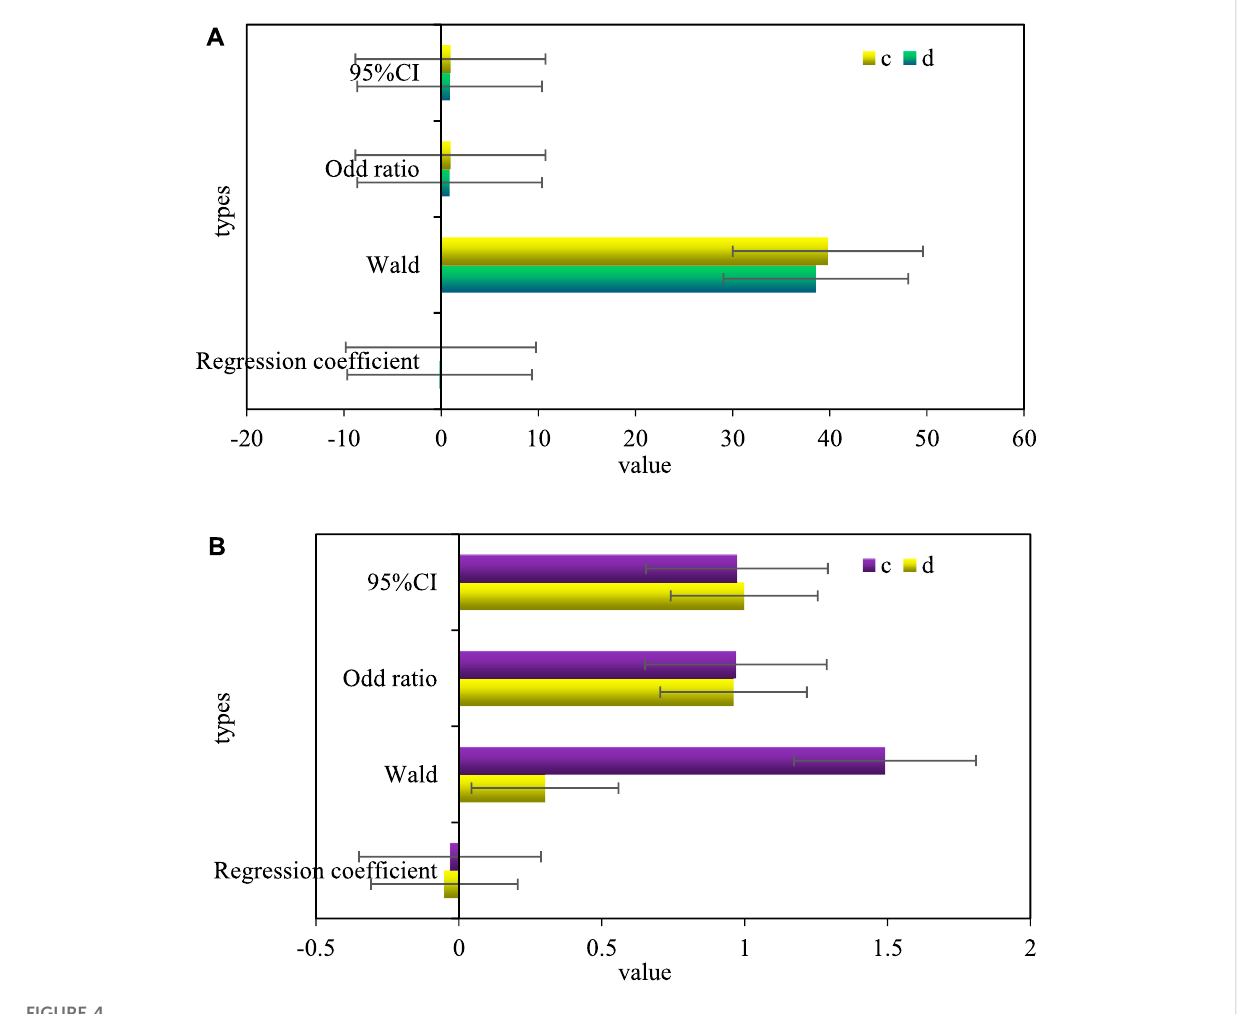
FIGURE 4 (A) Univariate logistic risk factor analysis of hemoglobin index and ureteral urothelial cancer. (B) Multivariate logistic risk factor analysis of hemoglobin index and ureteral urothelial